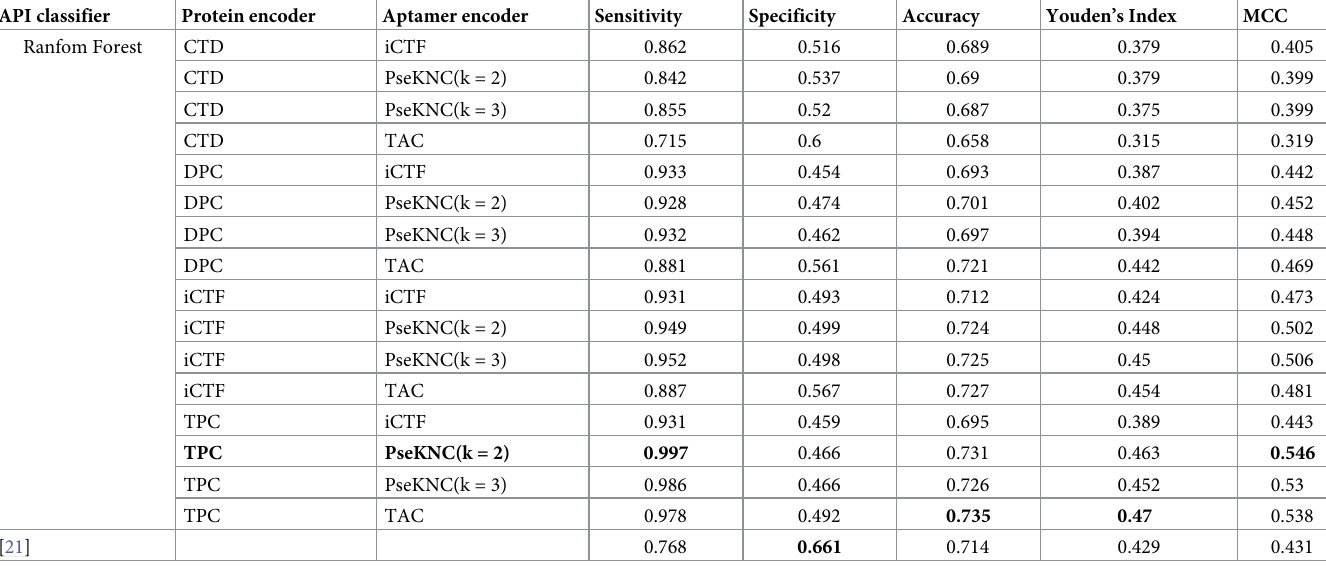
Table 4. Performance evaluation of various input encoding methods using the dataset of Lee and Han